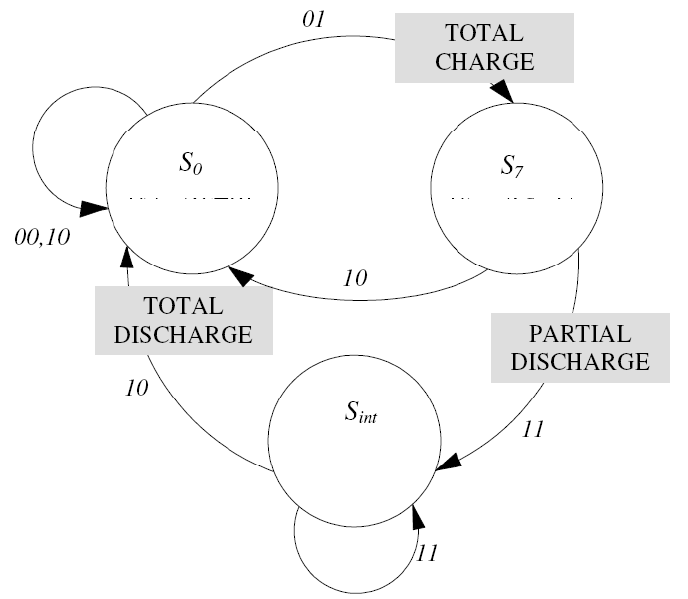
Figure 2. Control automaton that receives inputs I three outputs, coincident with its three distinguishable charge states ( S and S int